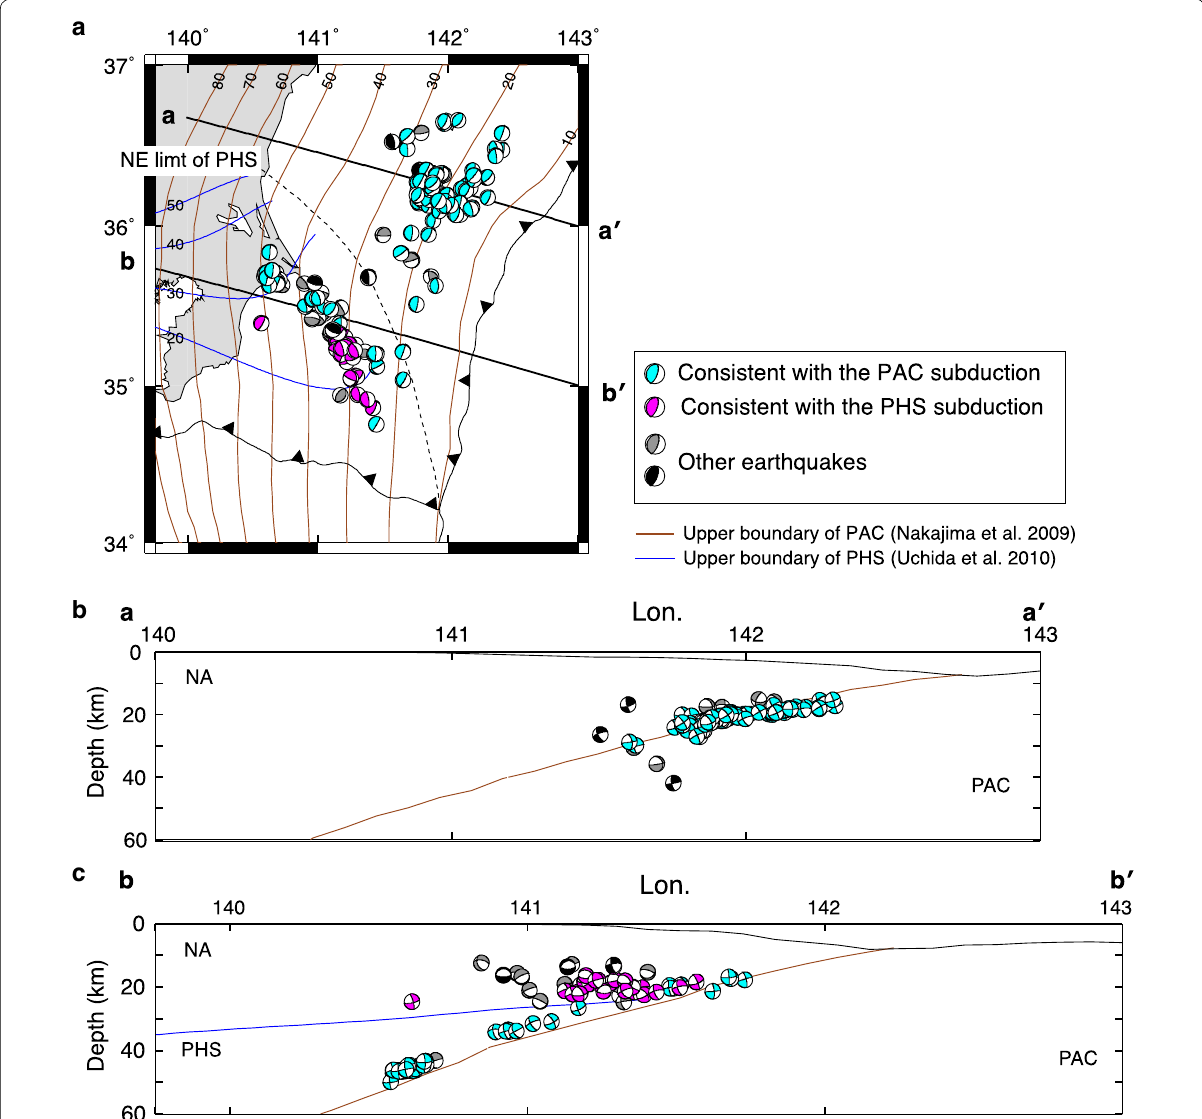
Fig. 6 Distribution and focal mechanisms of low-angle thrust-faulting earthquakes. The light blue and magenta beach balls indicate earthquakes associated with PAC and PHS subduction, respectively. The focal mechanisms, shown in black and gray, are earthquakes inconsistent with subduction. a Lines a–a ′ and b–b ′ define the projected lines onto the cross-sections. The brown and blue lines indicate the depths of the upper boundaries of the PAC (Nakajima et al. 2009) and PHS (Uchida et al. 2010), respectively. b Cross-section along line a–a ′ . The focal mechanisms north of the northeastern limit of the PHS are plotted. c Cross-section along line b–b ′ . The focal mechanisms south of the northeastern limit of the PHS are